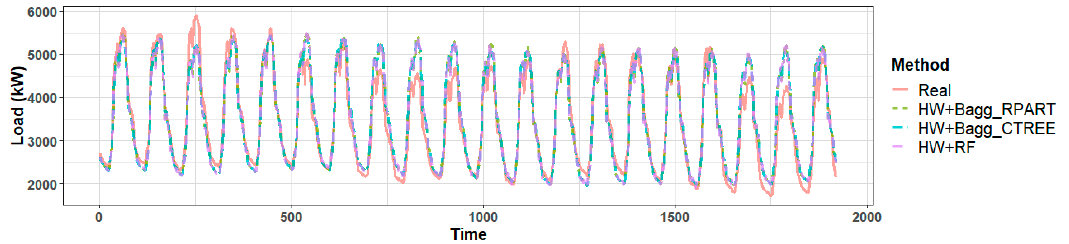
Figure 4. Comparison of ensemble learning forecast. Table 1. Accuracy based on test data.